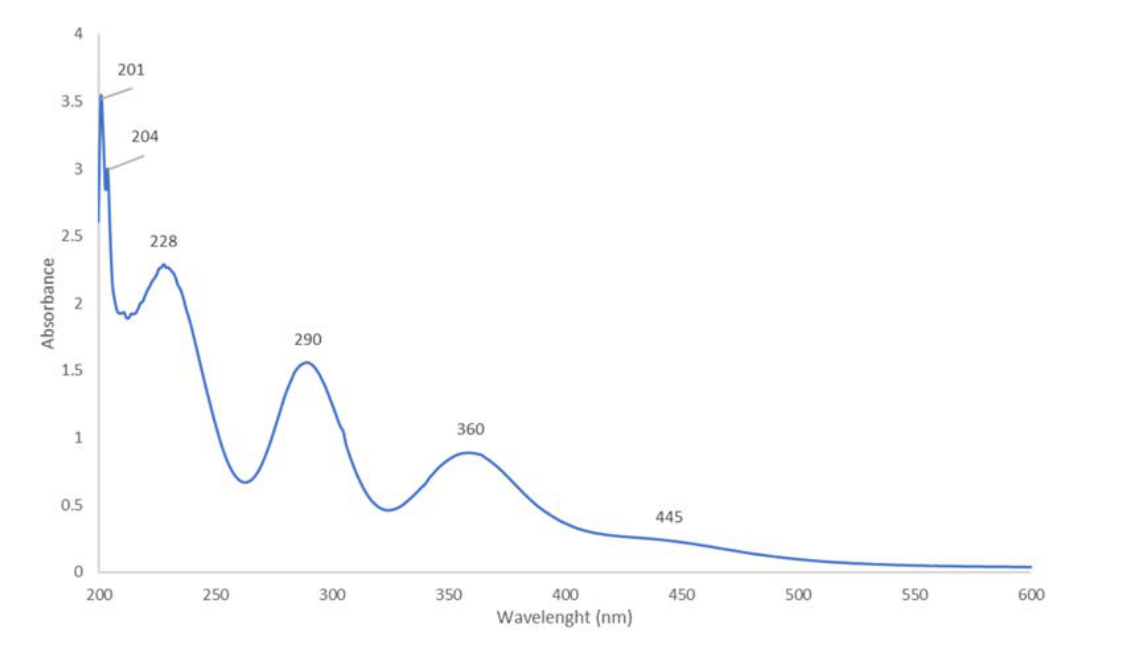
Figure 1. The UV ‐ vis analysis of [Cu(12 ‐ crown ‐ 4) 2 ]I 5 . Figure 1. The UV-vis analysis of [Cu(12-crown-4) 2 ]I 5 .